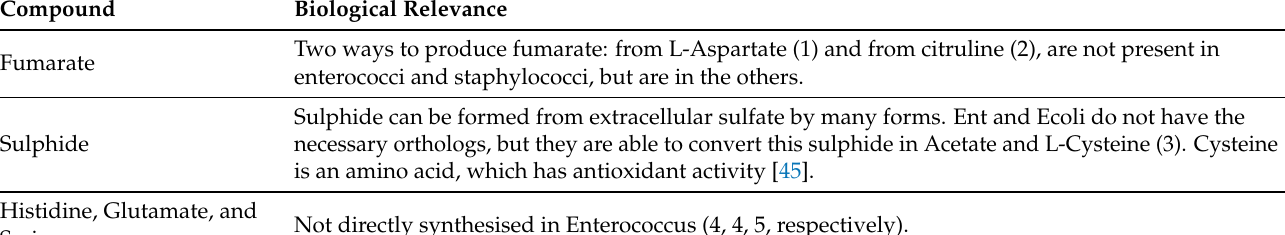
Table 2. Compounds proposed to be complemented in enterococci by other UTI species. The KEGG pathway images refer- enced in the text are (1) Alanine, aspartate, and glutamate metabolism; (2) Arginine biosynthesis; (3) Sulphur metabolism; (4) Histidine metabolism; (5) Glycine, serine, and threonine metabolism; (6) Folate biosynthesis; (7) One carbon pool by folate. Compound Biological Relevance Fumarate